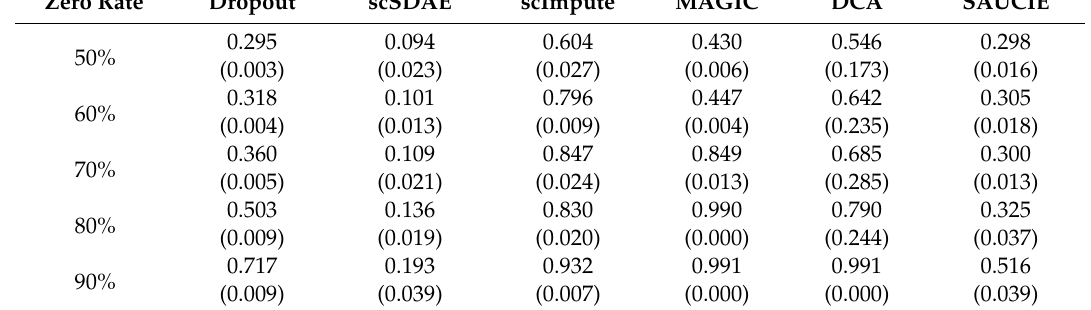
Table 1. The mean and standard deviation of the CMDs between the original and the dropout/imputed matrix.